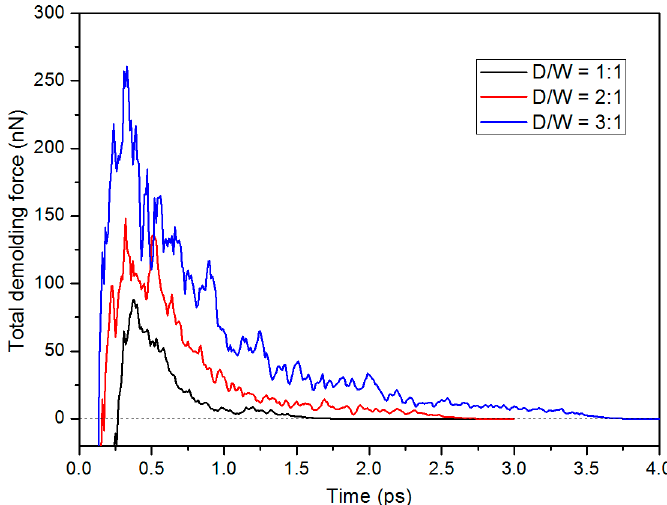
Figure 8. Total demolding forces of PP layer during the separation, with the D/W values of (lower curve) 1:1, (middle curve) 2:1, and (upper curve) 3:1.